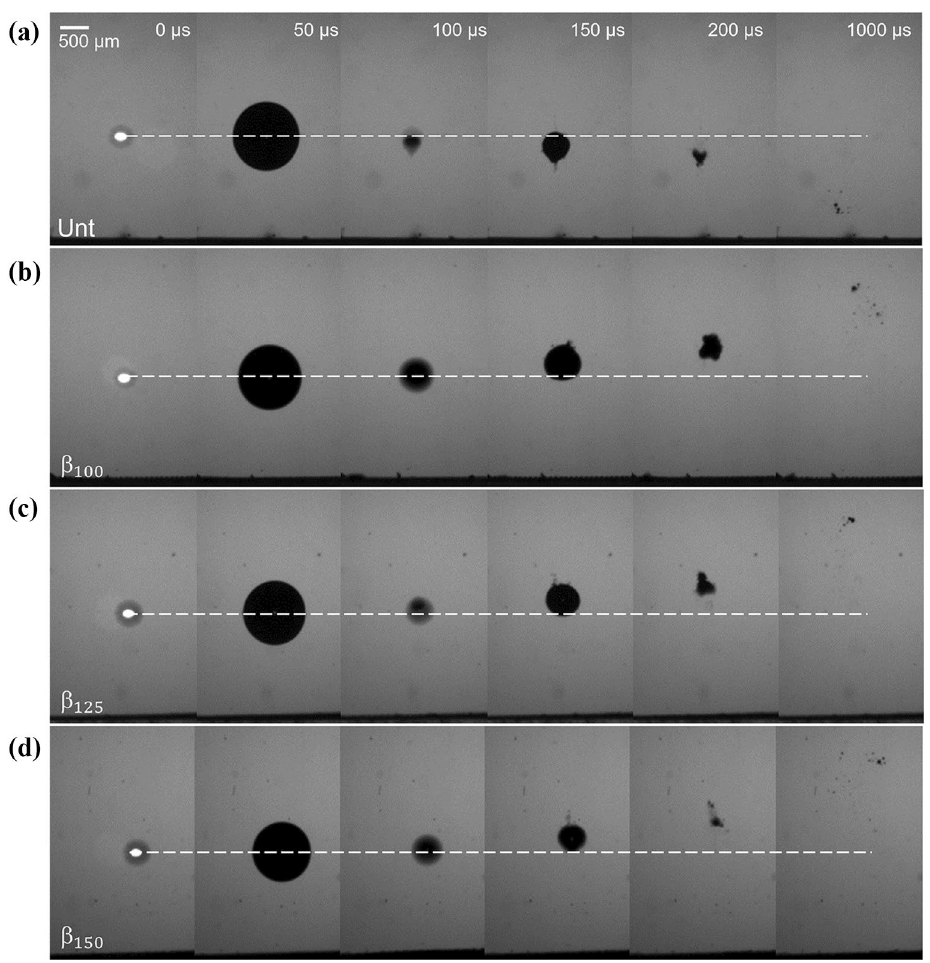
Figure 7. Comparison of a single cavitation bubble collapsing at a stand-off distance of γ = 3 from ( a ) untreated PDMS, ( b ) β 100 , ( c ) β 125 , and ( d ) β 150 microstructures. The black line at the bottom of each image is the surface.